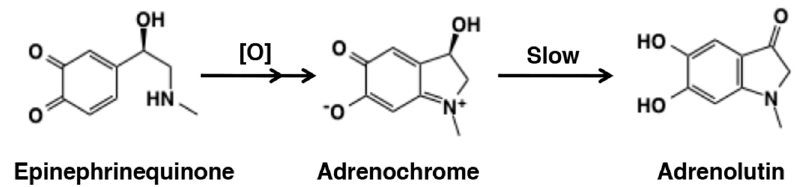
Figure 33. Reaction of epinephrinequinone [190]. The product adrenochrome gradually rearrange to adrenolutin (3,5,6-trihydroxy- N -methylindole).